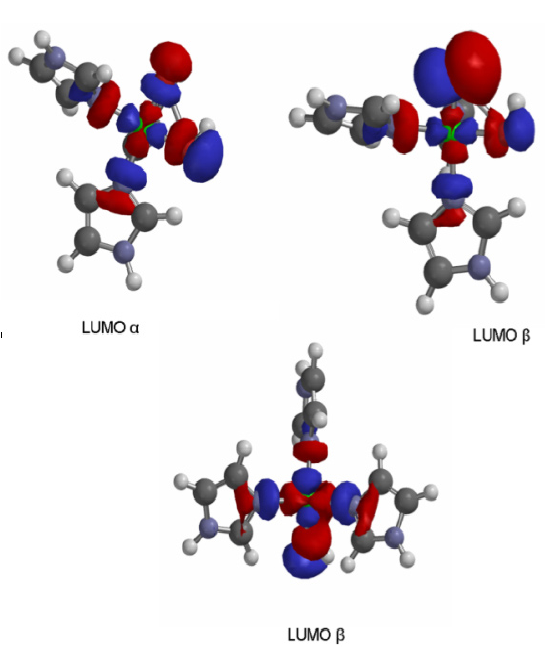
Figure 4. LUMO orbitals for model 7 (top row) and 4